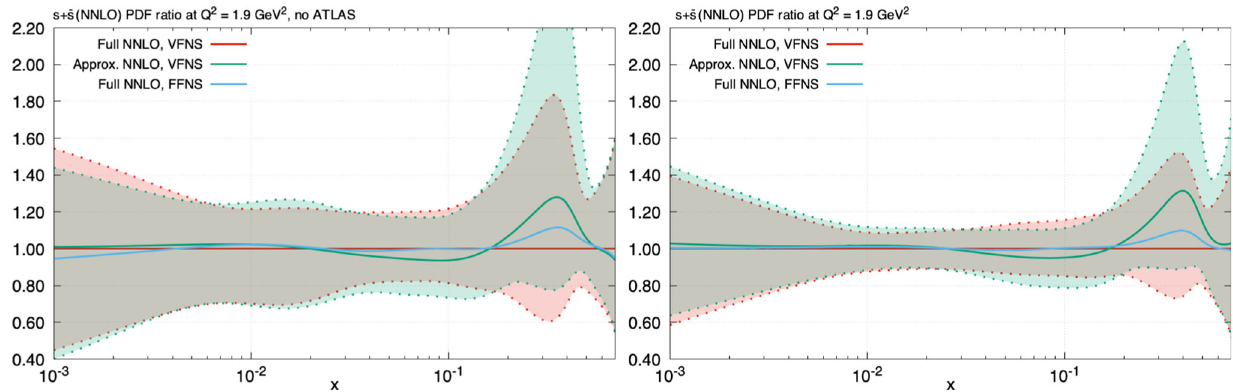
Fig. 56 The strangeness at Q 2 = 1 . 9 GeV 2 , for variants of the MSHT NNLO fits ( α S free). The ratio of the result with the previous approx- imate NNLO theory and the full NNLO theory (FFNS only) to the